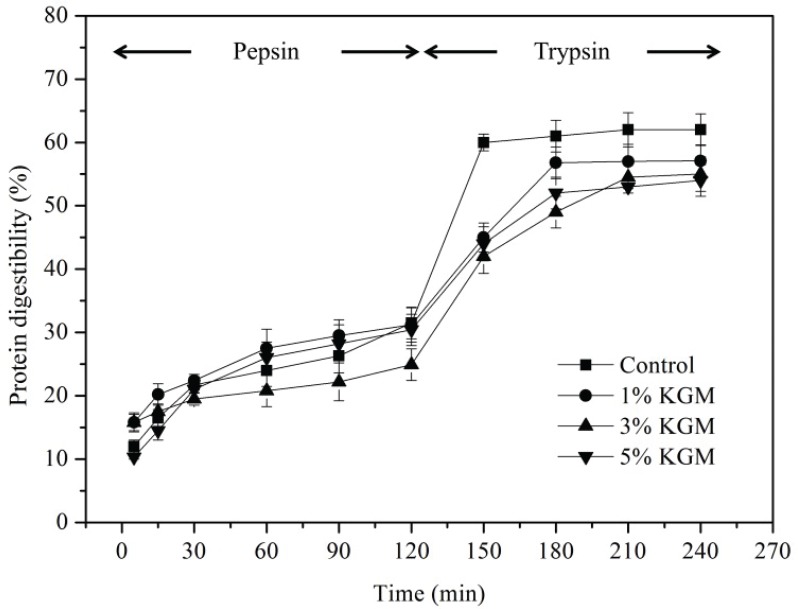
Digestibility of precooked wheat gluten substituted with KGM of different concentrations (1 wt%, 3 wt%, and 5 wt%).